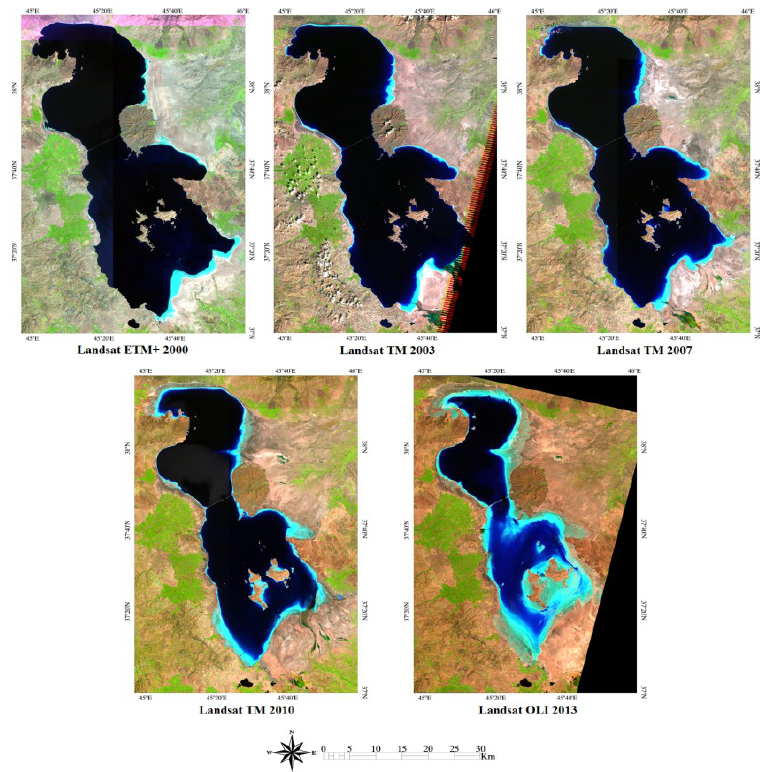
Figure 2. The dataset after pre-processing (RGB-543 false color